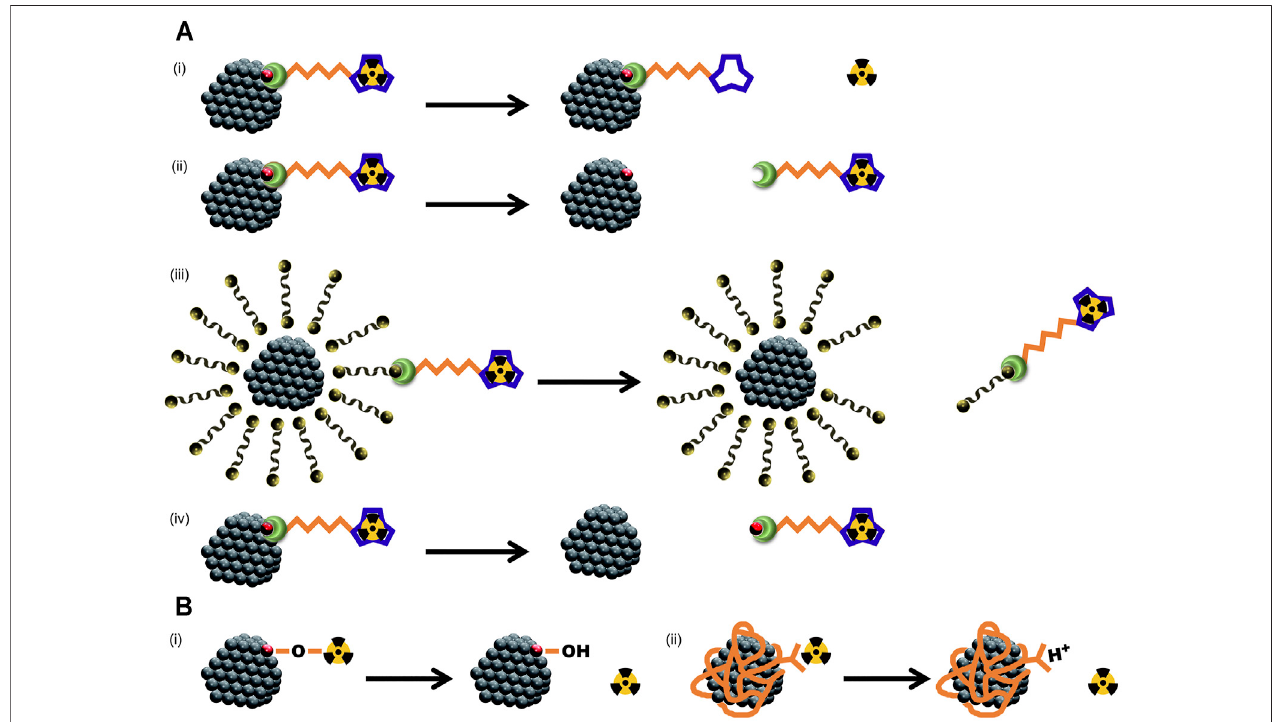
FIGURE 1 | Schematic diagrams for different types of radiometal detachment from NMs in vivo , especially at low pH milieu. (A) , reasons for the detachment after chelator-based radiolabeling: (i) compromised chelation; (ii) failed conjugation; (iii) weak bond between NMs and radiometal; (iv) decomposition of the NMs. (B) , reasons for the detachment after chemical adsorption radiolabeling: (i) desorption due to proton competition; (ii) carboxyl group protonation.